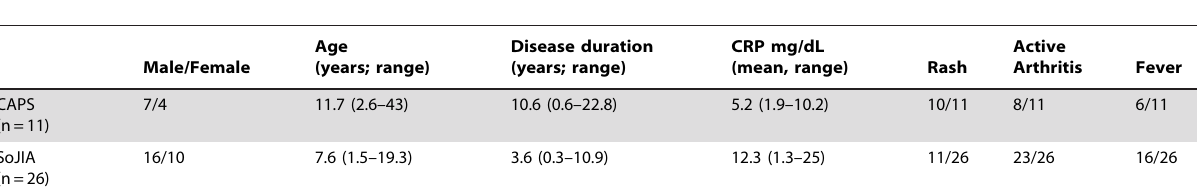
Table 1. Clinical characteristics of CAPS and SoJIA patients at the moment of the study.